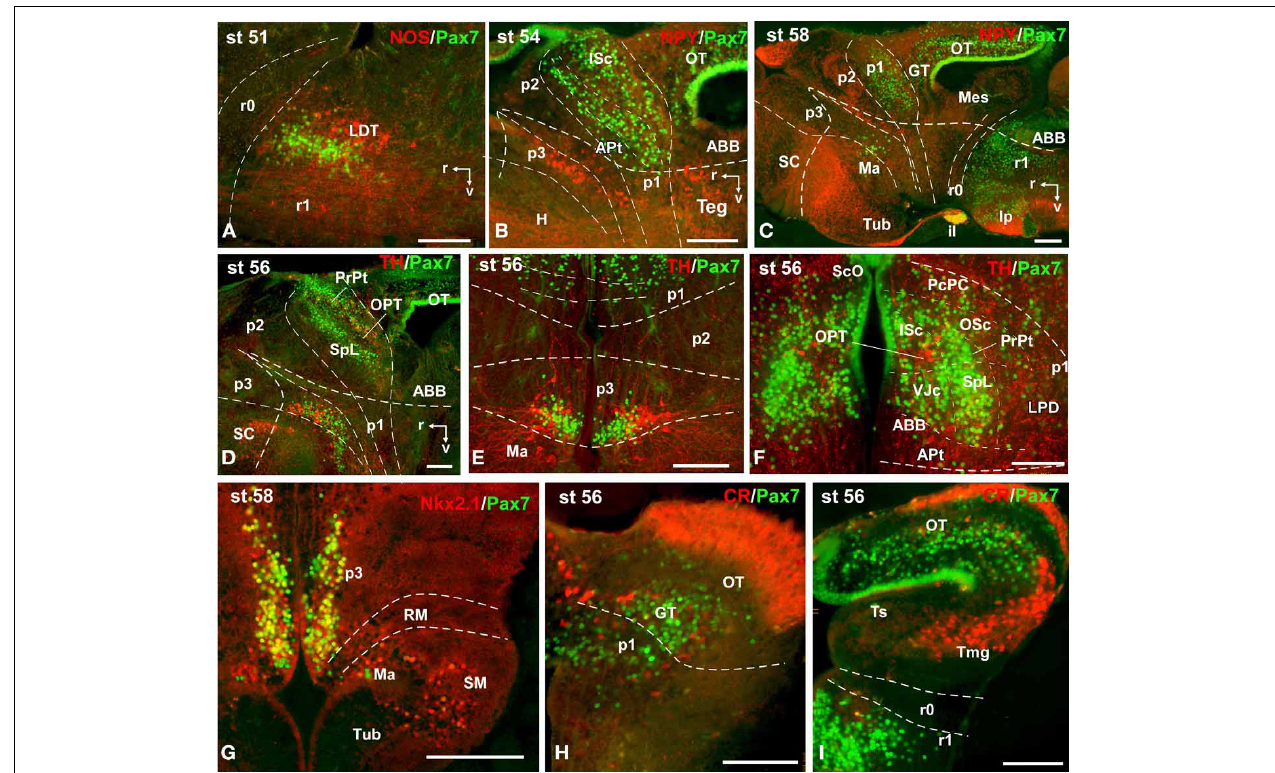
FIGURE 10 | Photomicrographs of double-labeled sagittal (A–D) and transverse (E–I) sections through the brain of Xenopus laevis showing the localization of Pax7 cells (green fluorescence) in relation to the markers NPY, TH, CR, Nkx2.1, and NOS (red fluorescence; indicated in color code in the upper right corner of each photomicrograph). The developmental stages are indicated in the